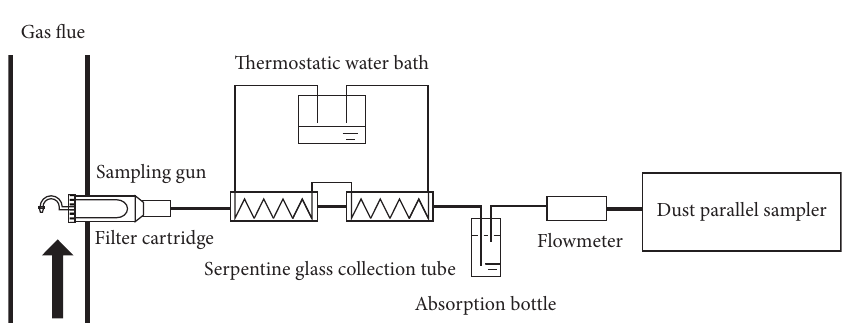
Figure 3: The sampling system of sulfuric acid aerosol.